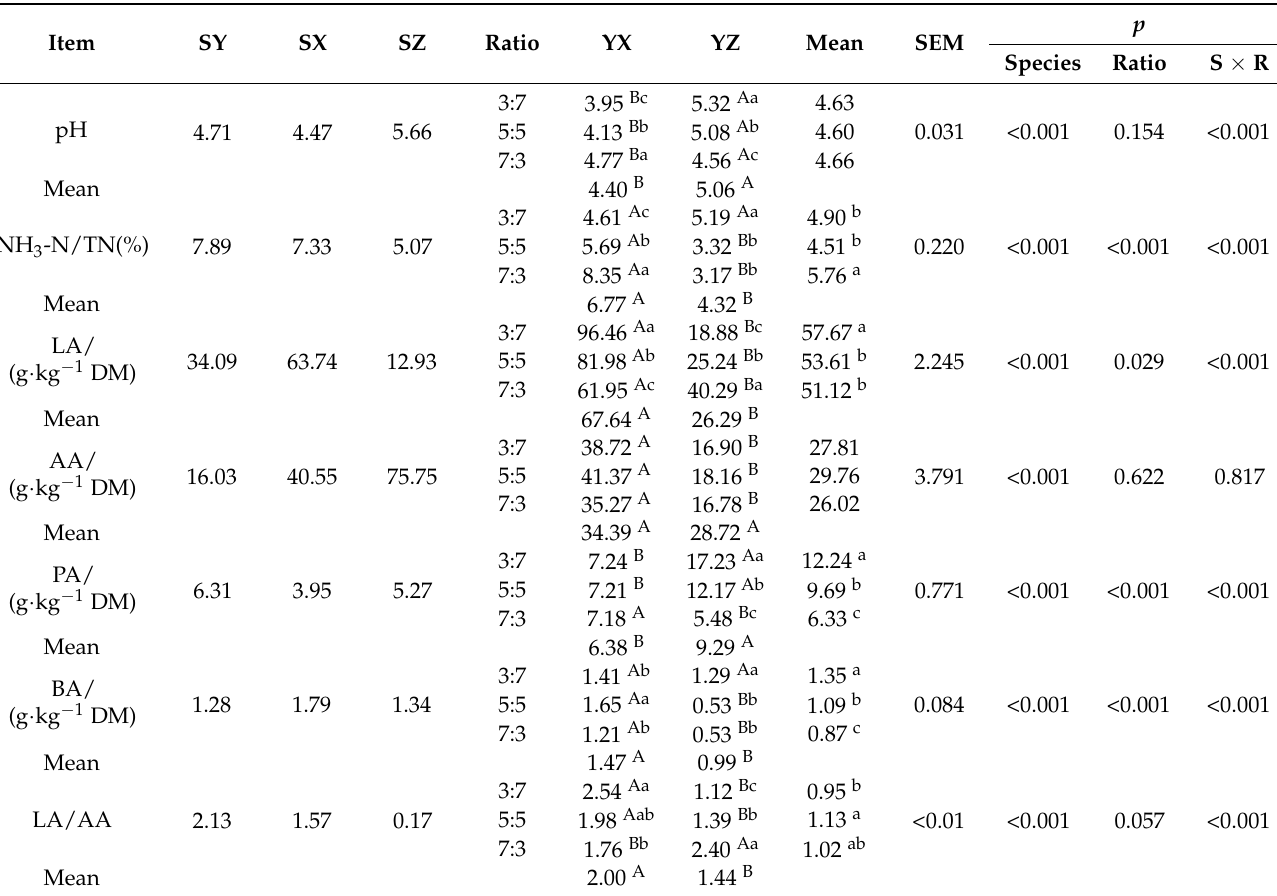
Table 6. Fermentation quality of the mixed silage of rapeseed with alfalfa or Myriophyllum spicatum in different proportions.